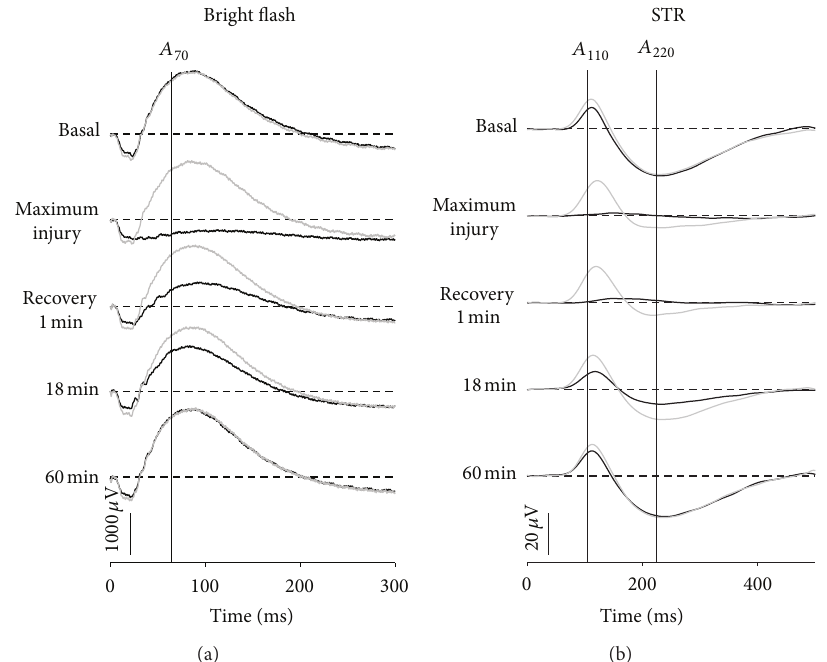
F 5: Recovery of bright �ash ((a) 42min (greyed traces) and 70mmHg for 30min (thick traces). Reprinted from [57] with permission. e Association for Research in Vision and Ophthalmology remains the copyright holder.